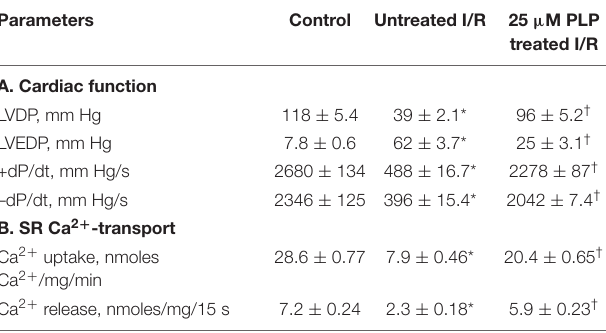
TABLE 3 | Effects of vitamin B 6 metabolite, pyridoxal 5 (cid:48) -phosphate (PLP), on cardiac function and sarcoplasmic reticular (SR) Ca 2 + -transport in rat hearts subjected to ischemia-reperfusion